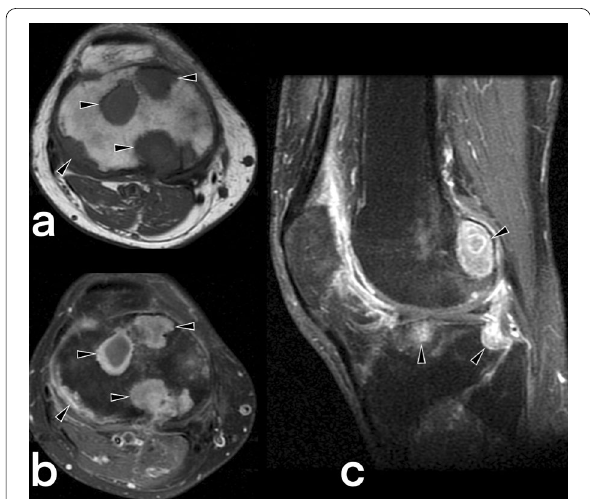
Fig. 54 MR images of a 60-year-old male. Pre-contrast axial ( a ), post-contrast axial ( b ), and sagittal ( c ) T1 weighted images reveal intraosseous abscesses (arrowheads) with peripheral enhancement in the distal part of the femur and proximal tibia